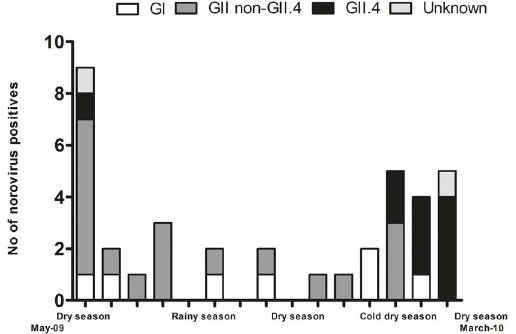
Figure 1. Temporal distribution of norovirus genogroups/ genotypes in Ouagadougou, Burkina Faso from end of May 2009 to March 2010; each tick representing 3 weeks. Rainy season (June-September), cold dry season